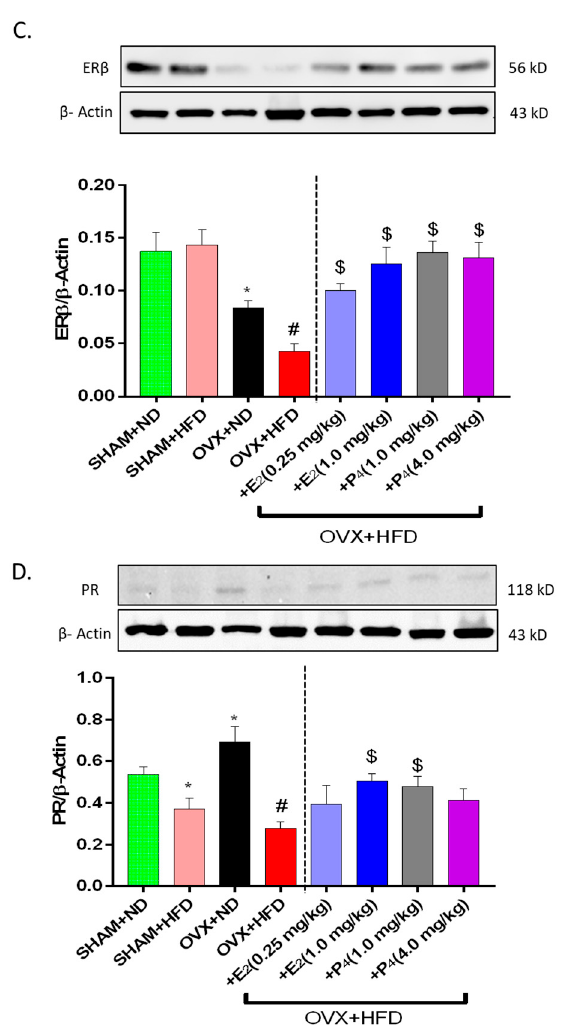
Figure 4. E ff ect of 17 β -Estradiol (E 2 ) and Progesterone (P 4 ) on protein expressions of estrogen receptor alpha (ER α ) and estrogen receptor beta (ER β ) and progesterone receptor (PR) and phospho-MAPK in gastric neuromuscular tissues of OVX mice fed an HFD. Representative immunoblot and densitometric analysis data for ( A ) p-MAPK, ( B ) ER α , ( C ) ER β , ( D ) PR protein expression in female mice gastric neuromuscular tissue. Stripped blots were re-probed with β -actin. Data were normalized with housekeeping protein ( β -actin). Bar graphs showed a ratio of target gene or protein with β -actin. Data were analyzed using one-way ANOVA by using graph pad prism software. The values are mean ± SEM ( n = 4). * p < 0.05, significantly di ff erent from normal diet-fed sham-operated (SHAM + ND) mice. # p < 0.05, significantly di ff erent from normal diet-fed ovariectomized (OVX + ND) mice. $ p < 0.05, significantly di ff erent from high-fat diet-fed OVX (OVX + HFD) mice. 3.7. Gastric Pro-inflammatory Cytokine (IL-6 and TNF α ) are Elevated in HFD-fed Mice and Restored by E 2